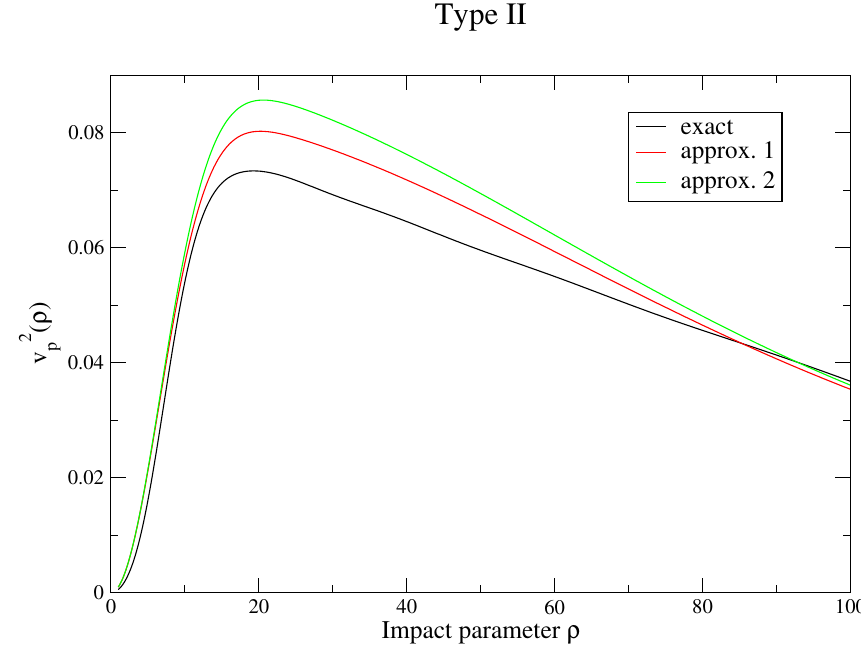
Figure 9. Comparison between the exact computation of v 2 p ( ρ ) and the approximate expressions v p,app (see Equation (63)) and v p,app,2 (see Equation (68) for n α = 8, (cid:96) α = 3, m α = 2, (cid:96) α (cid:48) = 2, and m α (cid:48) = 1, n β = 3, (cid:96) β = 2, m β = 2, (cid:96) β (cid:48) = 1, and m β (cid:48) = 1 (Type II).